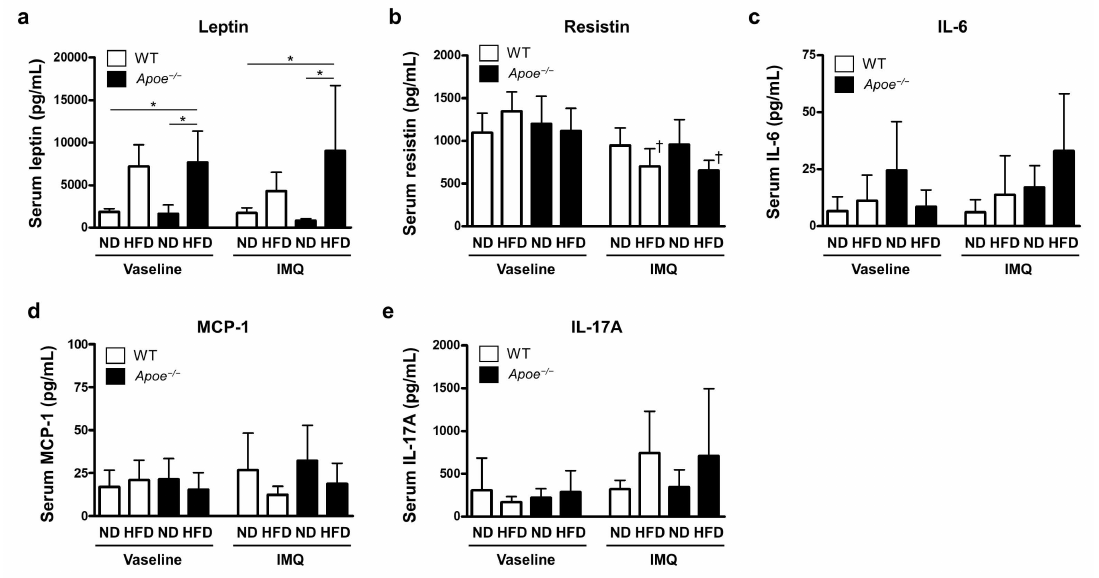
Figure 4. Measurement of multiple adipokine levels in the mouse serum: ( a – d ) Serum levels of leptin, resistin, IL-6, and MCP-1. Serum samples were collected from wild-type and Apoe − / − mice fed with a normal diet or a high-fat diet and treated with imiquimod cream (25 mg/mouse) or Vaseline (control) ( n = 6 per group). Serum adipokine levels were measured by multiplex assay. ( e ) Serum IL-17A concentrations determined by ELISA. Values are presented as the mean ± standard deviation; * p < 0.05, † p < 0.05, compared to Vaseline-treated mice. IMQ, imiquimod; WT, wild-type; ND, normal diet; HFD, high-fat